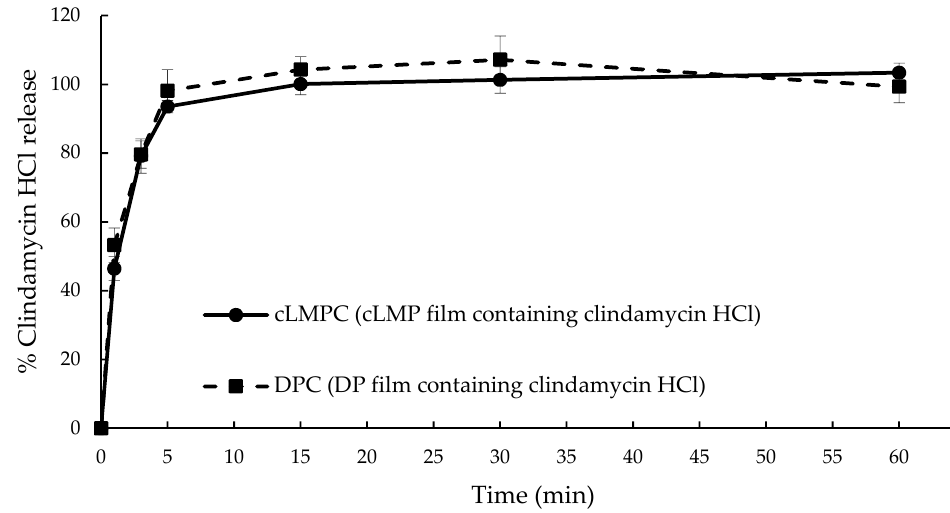
Figure 8. The dissolution profile of pectin films containing clindamycin HCl in tris buffer solution, pH 7.4, at time intervals ranging from 0 to 60 min.